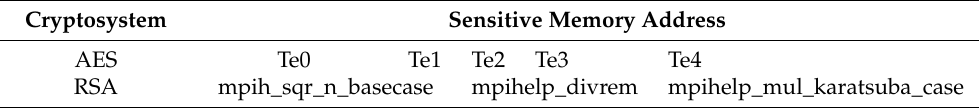
Table 1. Cache attack library.